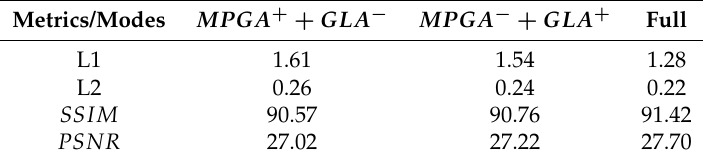
Figure 9. Ablation study of the proposed modules in the Places365 dataset [21]. From left: input image, without the MPGA module, without the GLA module, full model with the proposed modules, and the ground truth. Table 5. Ablation study of the proposed modules in Places365 dataset